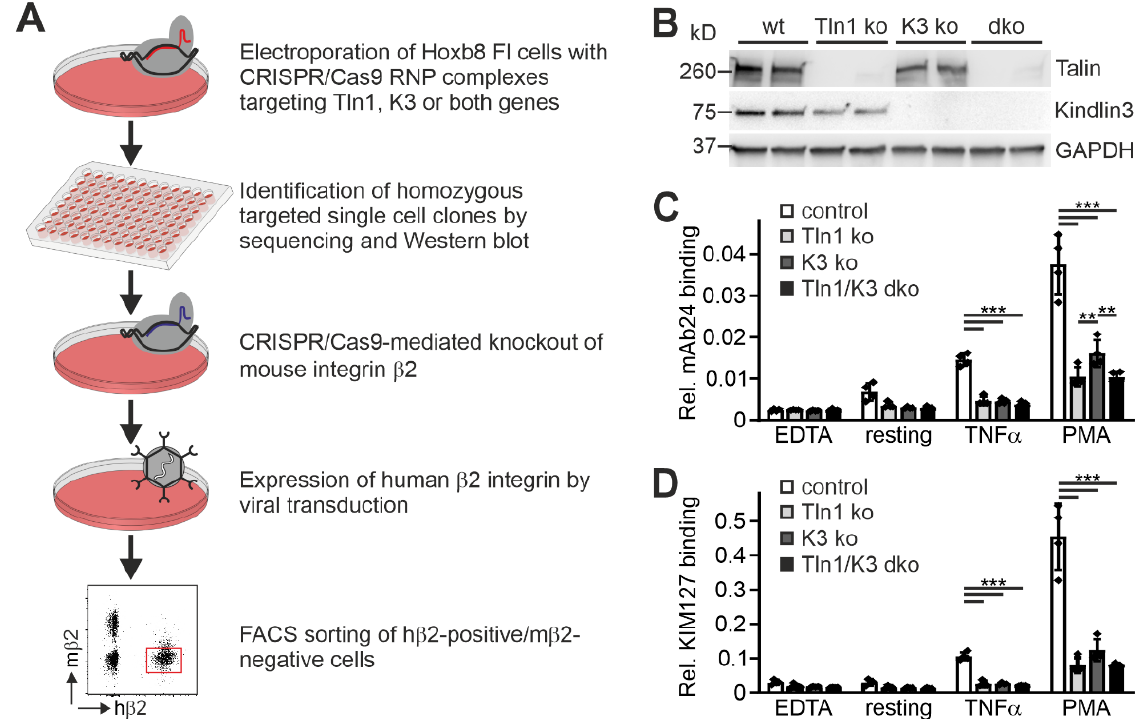
Figure 4. Both talin1 and kindlin3 are required for β2 integrin activation. ( A ) Scheme of workflow. Talin1, kindlin3, and talin1/kindlin3 double-deficient Hoxb8 FL cells were generated via the CRISPR/Cas9 system. Single cell clones were screened for talin1 and kindlin3 expression. Four clones per genotype were subjected to CRISPR/Cas9- mediated integrin β2 ablation and re trovirally transduced to express human integrin β2. Mouse integrin β2 - negative and human integrin β2 -positive cells were FACS-sorted. ( B ) Western blot analysis of neutrophil-like cells differentiated from different human integrin β2 expressing Hoxb8 single cell clones, in which talin1 and/or kindlin3 were ablated with the CRISPR/Cas9 system. GAPDH served as loading control. ( C , D ) Relative mAb24 ( C ) and KIM127 ( D ) binding to neutrophil-like cells derived from Hoxb8 single cell clones, expressing human integr in β2 and lacking talin1 and/or kindlin3 expression. N = 4 clones. Result of each clone is plotted as individual data point. All values are given as mean ± SD. ** p < 0.01, *** p < 0.001.